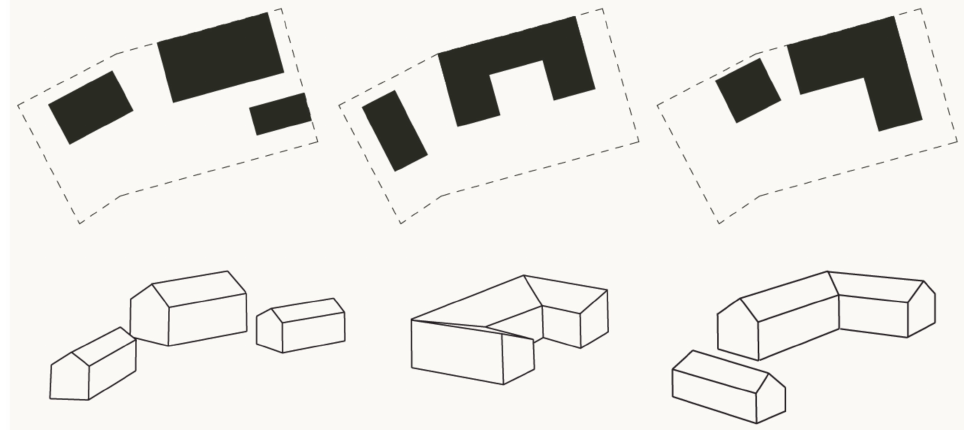
Figure 11. Building massing alternatives.